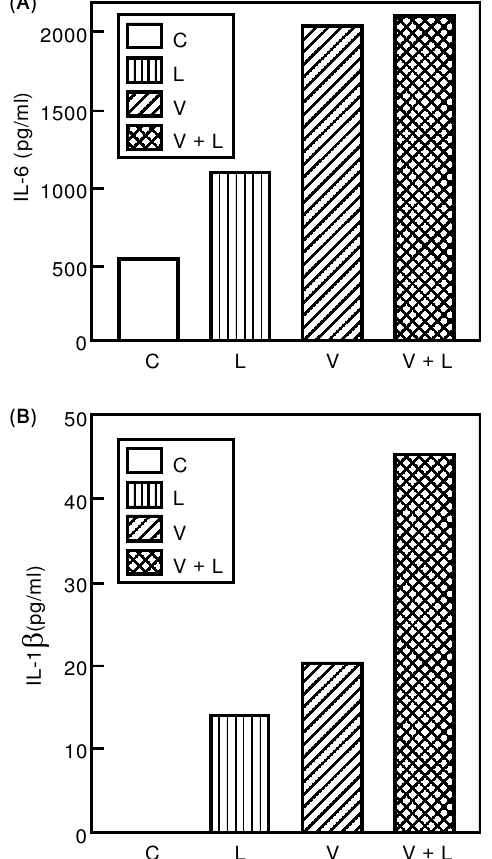
FIG. 2. Vaccinia virus and LPS effects on IL-6 and IL-1 b secretion from human skin fibroblasts. IL-6 (A) and IL-1 b (B) secretion was evaluated by ELISA in control (C), vaccinia virus infected (V–at MOI 4:1) and/or LPS treated (L) human skin fibroblasts at 24h. The results come from a single